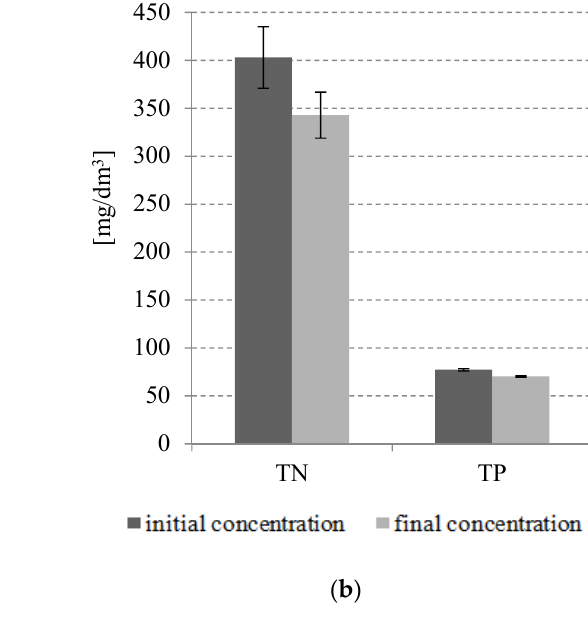
Figure 3. Trends in ( a ) organic levels, ( b ) nutrient levels.